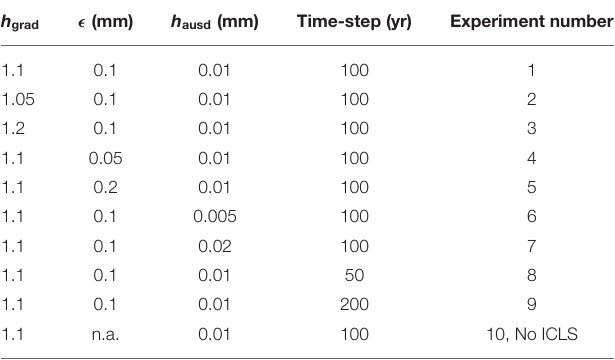
TABLE 1 | Parameters used for the sensitivity test of mass